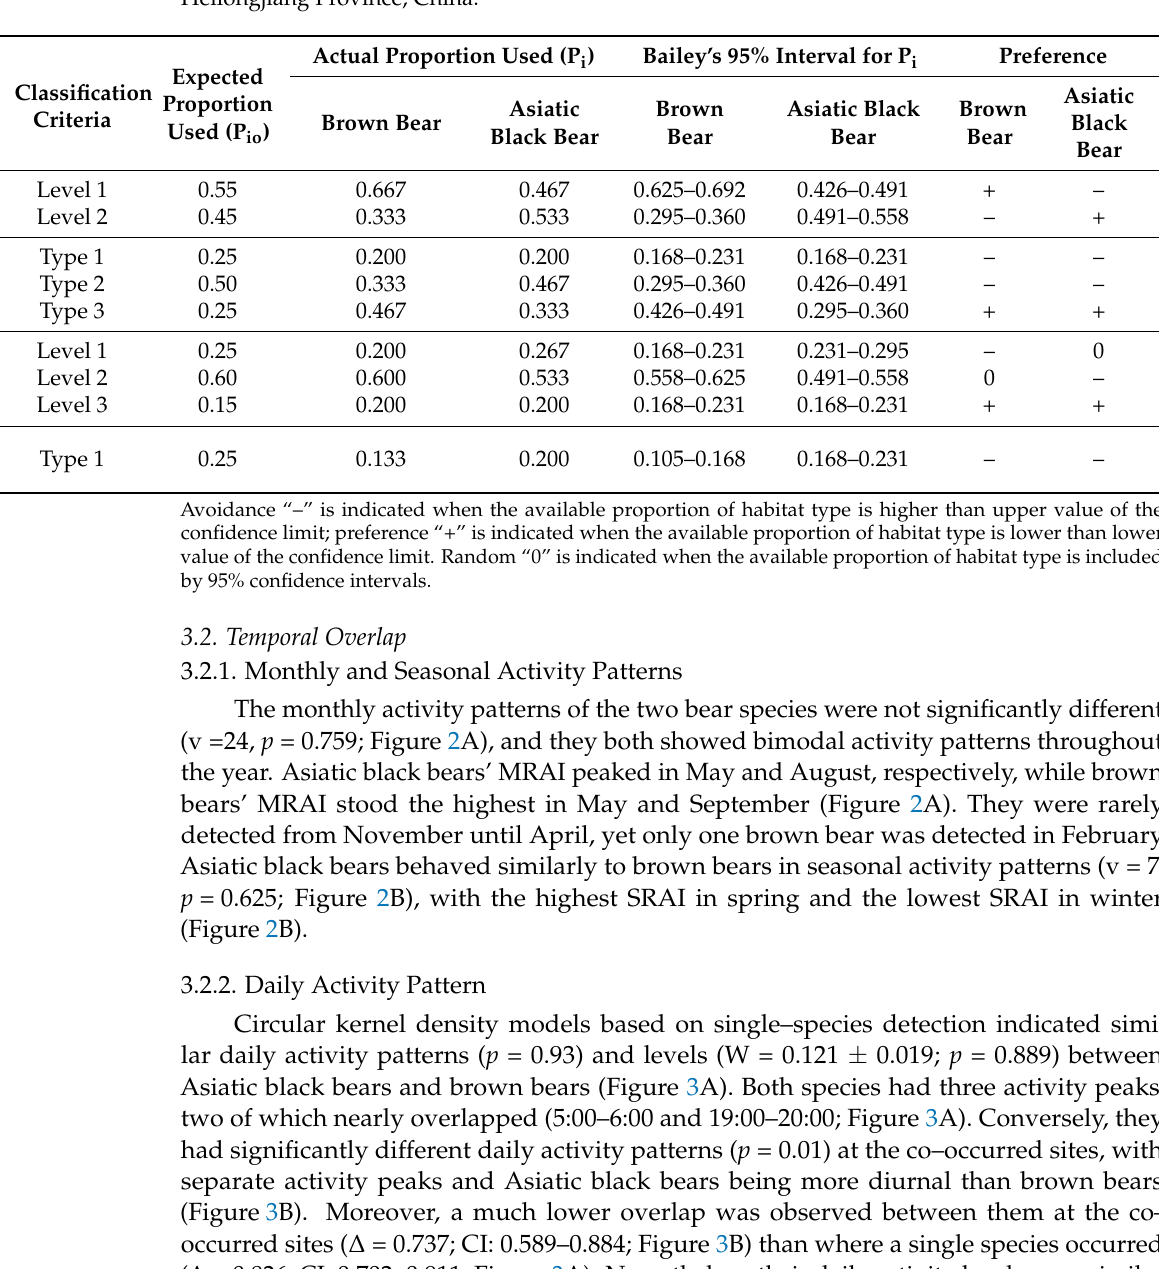
Table 2. Habitat use of Asiatic black bear and brown bear in Taipinggou National Nature